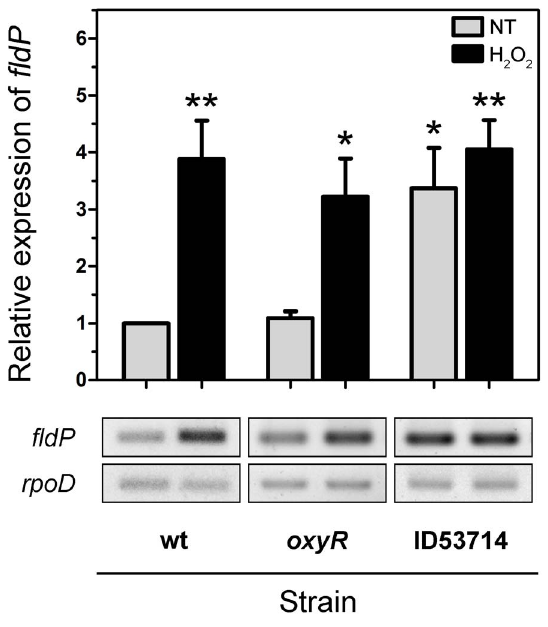
Figure 6. Induction and regulation of fldP expression. Total RNA was extracted from cultures (OD 600 =0.8) of wt, oxyR and ID53714 (PA14_22550 mutant) strains of P. aeruginosa which had been treated with 50 mM H 2 O 2 for 15 min or left untreated (NT). Semi-quantitative RT-PCR was performed with specific primers for fldP and the amplification products resolved by agarose gel electrophoresis. The rpoD transcripts were used as housekeeping controls. The upper panel shows relative expression levels averaged over at least 4 experiments (means 6 SEM), with NT expression of the wt strain normalized to 1. Statistically significant differences at P , 0.005 and P , 0.05 are identified by ** and *, respectively (two-tailed Student’s t test). The lower panels illustrate typical results obtained with fldP and rpoD